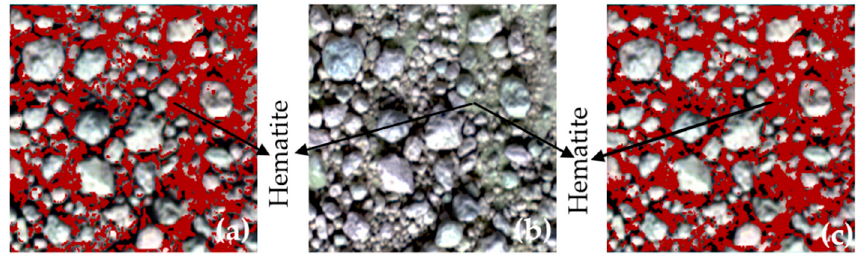
Figure 4. The original image ( b ) of Soil 1 at the beginning of the experiment is in the middle. Using Spectral Information Divergence (SID) classifier with a threshold value of 0.15, hematite (cherry color) occurrence over the image was defined. The image classification results, on the left ( a ) and the right side ( c ), were obtained using the Analytical Spectral Device (ASD) and the USGS spectral data, respectively. The black arrows indicate the hematite in the original image and its classification results for both the ASD and the USGS spectral data used.